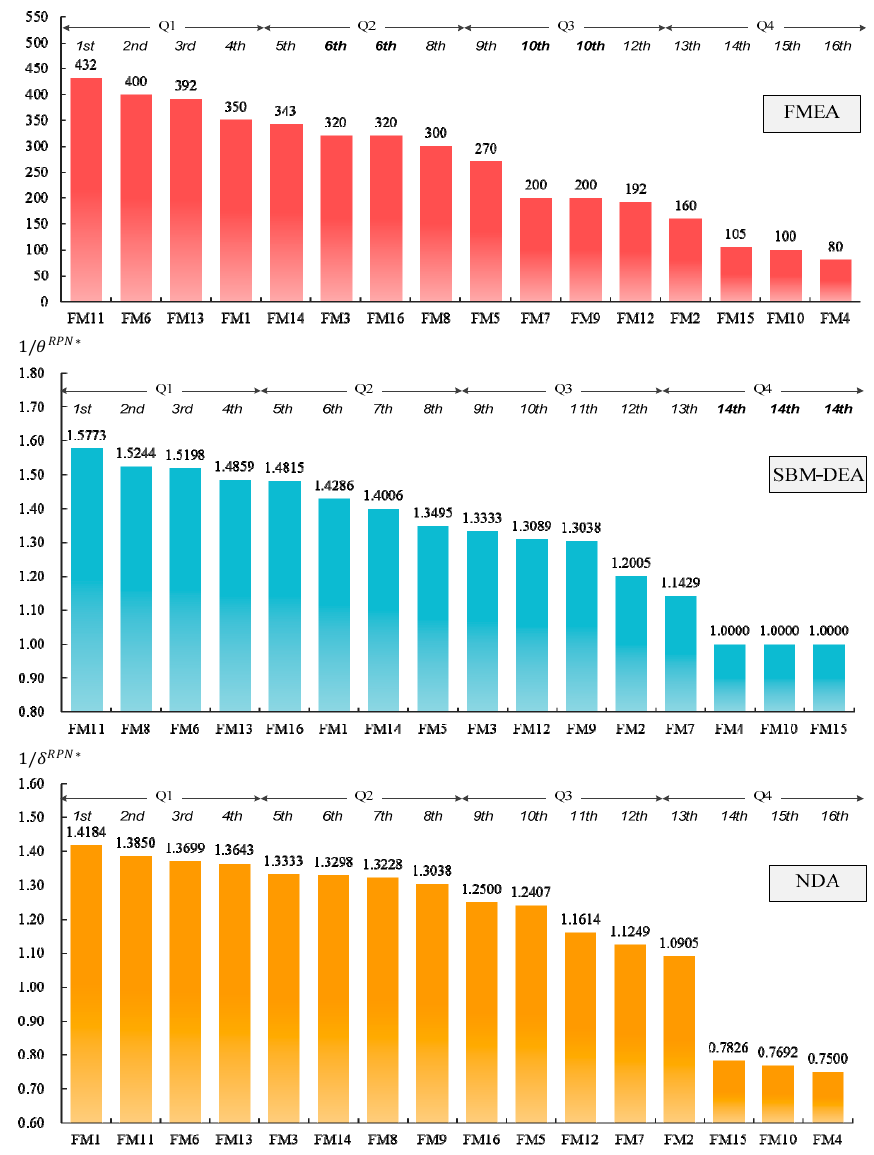
Figure 2. Prioritization of failure modes from risk priority number (RPN), slack-based measure (SBM) and our approach. FMEA: failure mode and effects analysis; SBM-DEA: slacks-based measure; NDA: data-driven approach.